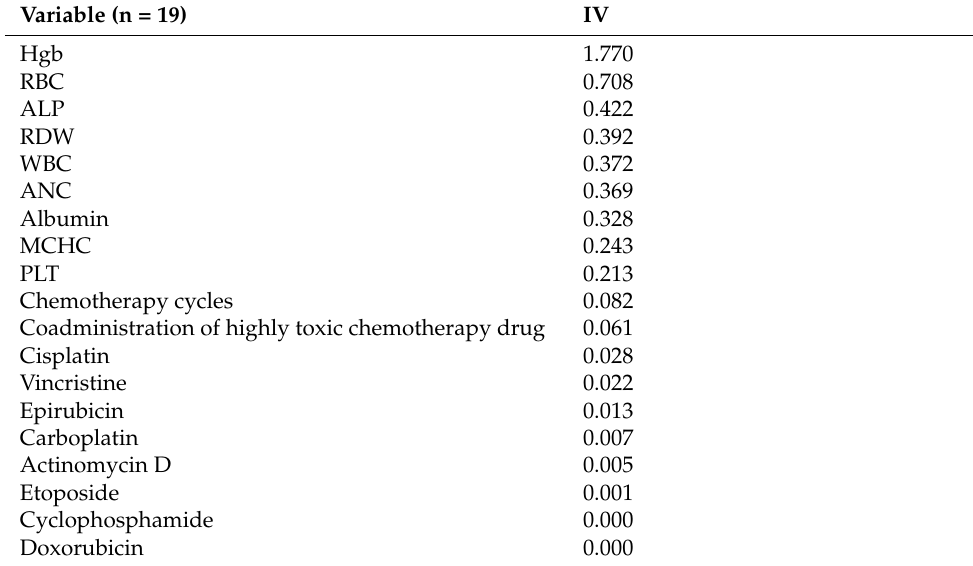
Table 5. Variables finally included in the